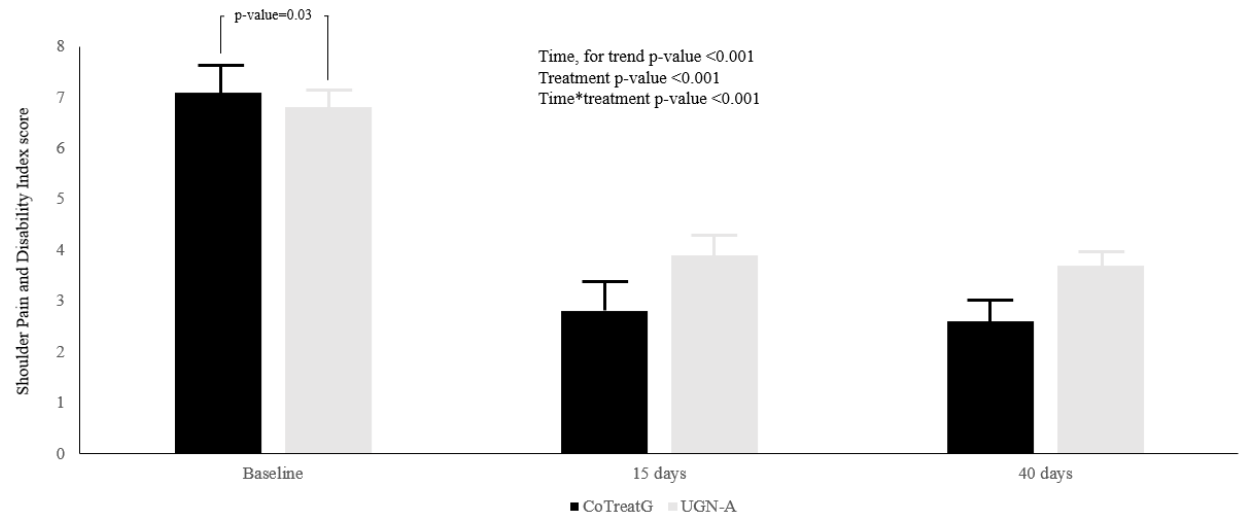
Figure 1. Shoulder Pain and Disability Index score was reported as mean ± S.E. The black bars represent the UGN plus BEN treatment group (CoTreatG), whereas gray bars represent the UGN-alone treatment (UGN-A). The differences between treatment were assessed with Linear Mixed Models, and were reported by the p -value for: Time, Treatment and the interaction between Time × Treatment.